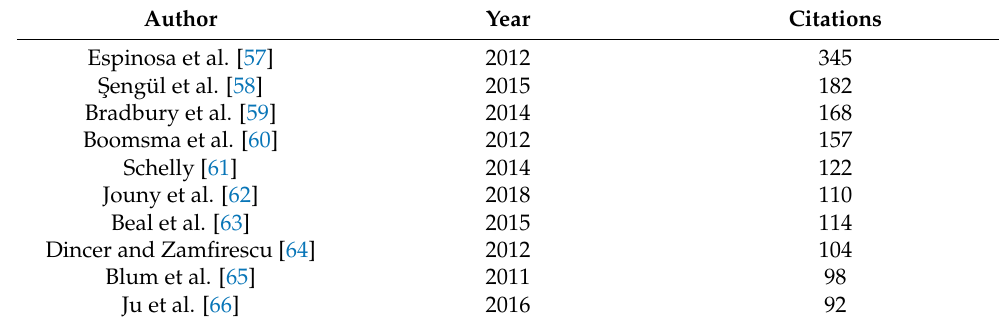
Table 4. Most Cited Papers (TPEM).